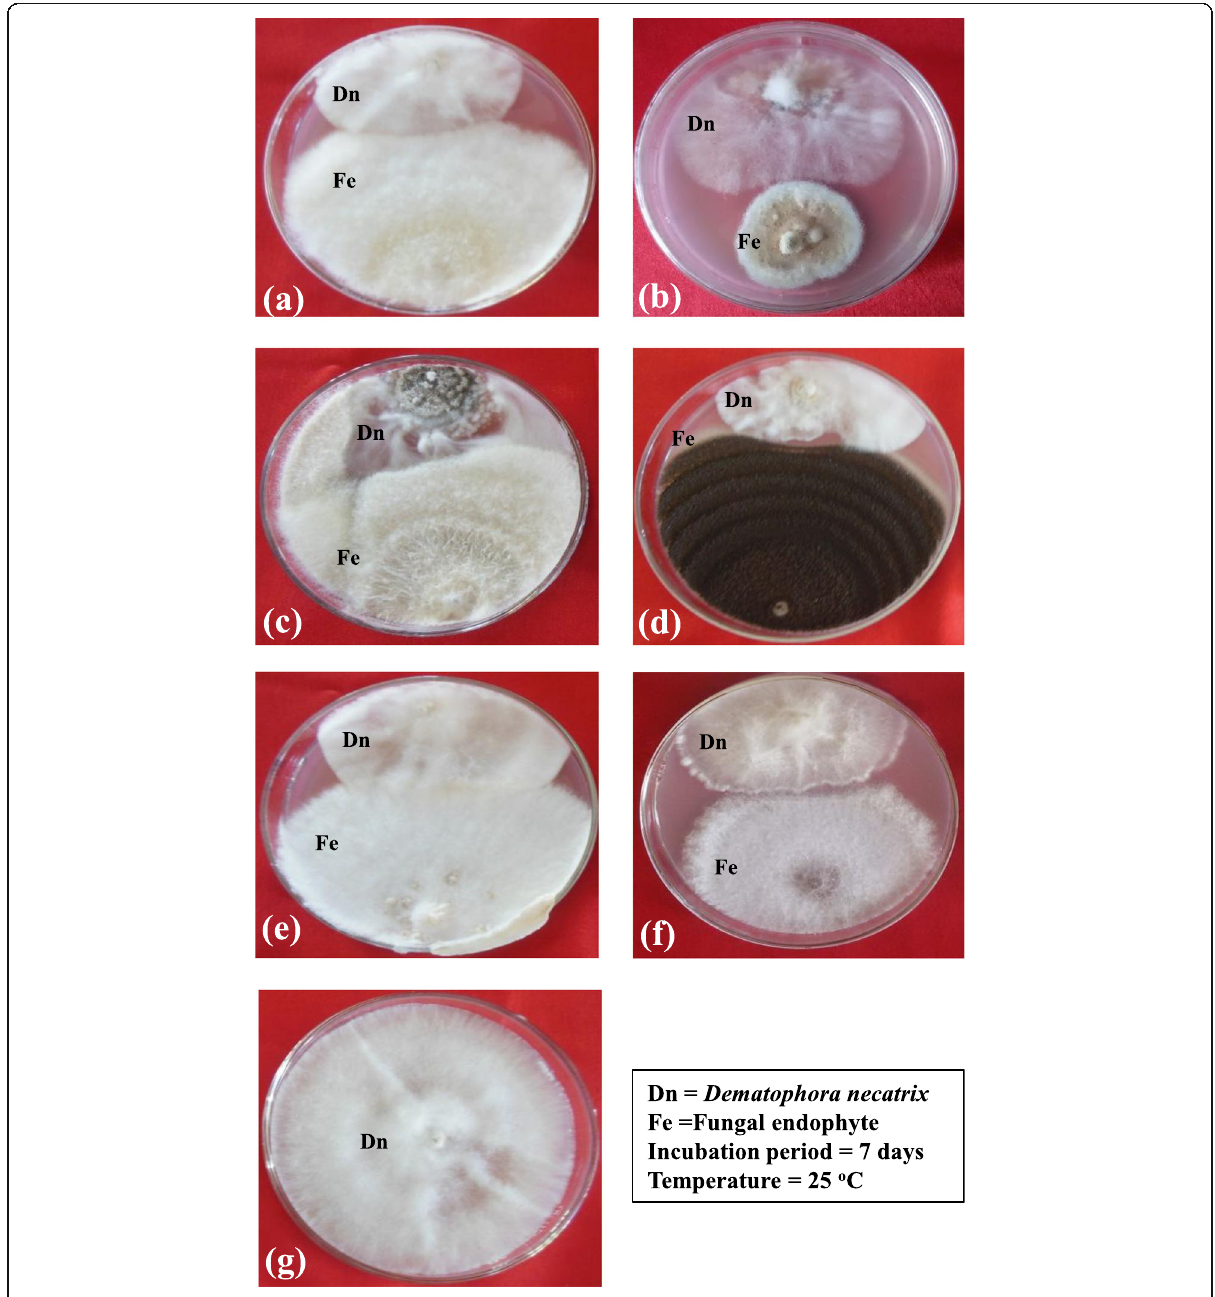
Fig. 2 In vitro activity of fungal endophytes [ a Fusarium equiseti strain M1, b Talaromyces aculeatus strain Ap, c Neocosmospora perseae strain G, d Aspergillus aculeatus strain C2, e Crinipellis tabtim strain M8, f Fusarium circinatum strain K3, and g control] against D . necatrix , causing white root rot of